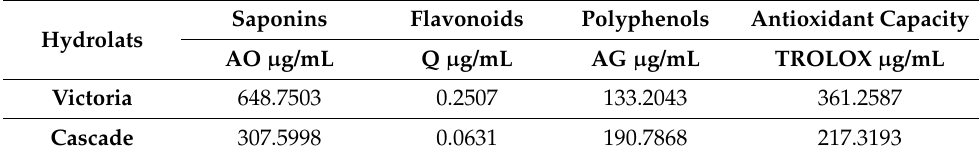
Table 2. Content of saponins, polyphenols, flavonoids, and antioxidant capacity of the different hydrolats from Humulus lupulus female flower cones of Mapuche, Cascade, Spalt, and Victoria